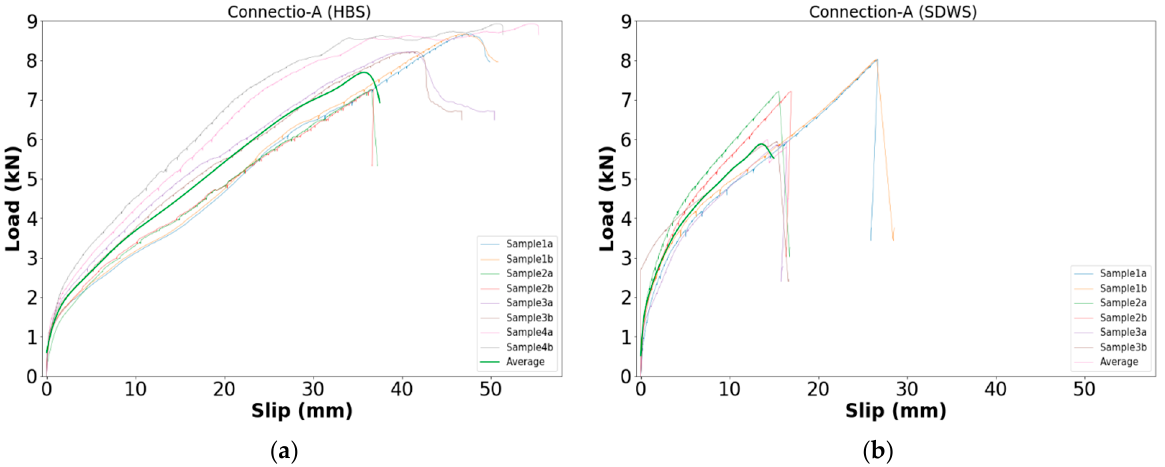
Figure 17. Load-slip curve of Connection-A: ( a ) HBS screw; ( b ) SDWS screw.